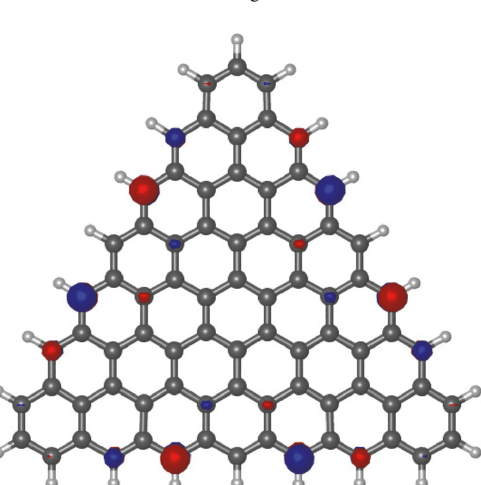
Figure 21: T 7 magnetic orbital 5.